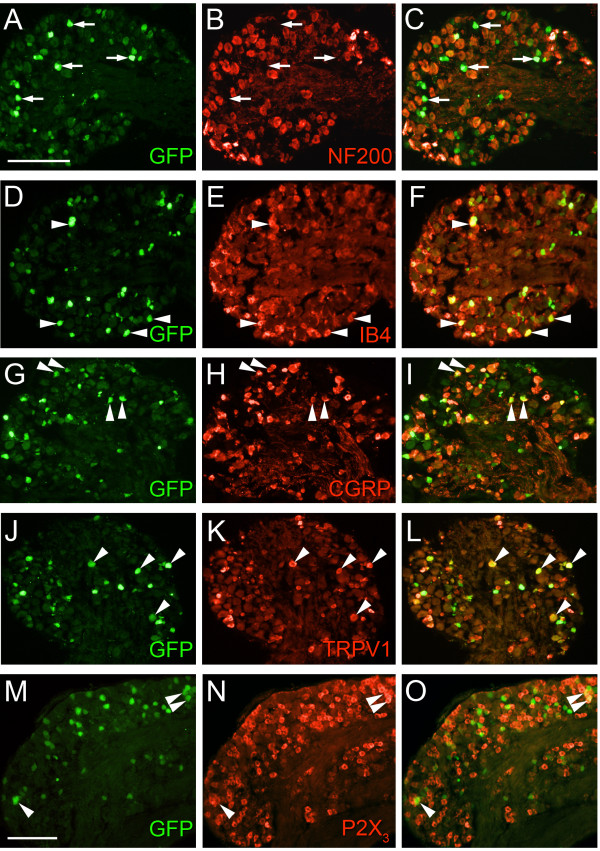
GFP expression in peptidergic and non-peptidergic nociceptive primary sensory neurons in Pde1c BAC transgenic mice. Lumbar DRG neurons from Pde1c BAC transgenic mice were stained with antibodies against GFP (green) to detect GFP-Pde1c expressing cells and with the lectin IB4 or antibodies against various sensory neuron markers (red). Arrows denote examples of GFP-immunoreactive cells negative for NF200 immunoreactivity (A-C). Arrowheads mark examples of GFP-immunoreactive cells double labeled for a given marker, evident in the overlay in the right panel (D-O). Images were taken using a wide-field fluorescence microscope. Scale bar, 100 μm in A applies to A-L; 100 μm in M applies to M-O.